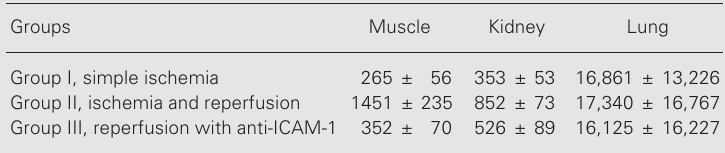
Table 1. Neutrophil concentration per mg of tissue in the different groups. Groups